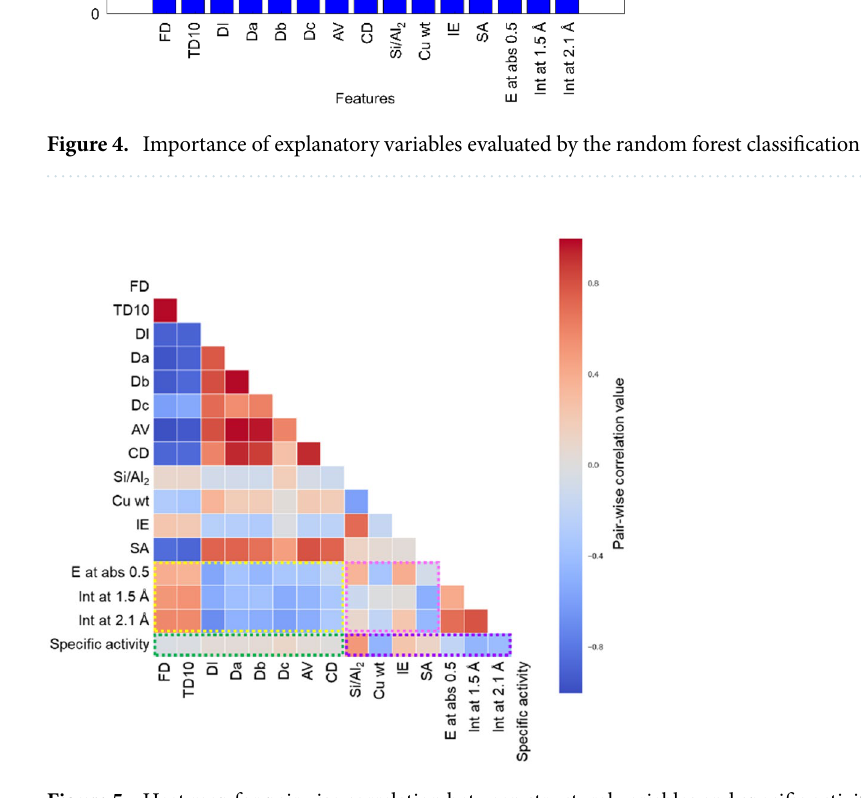
Figure 5. Heat map for pairwise correlation between structural variables and specific